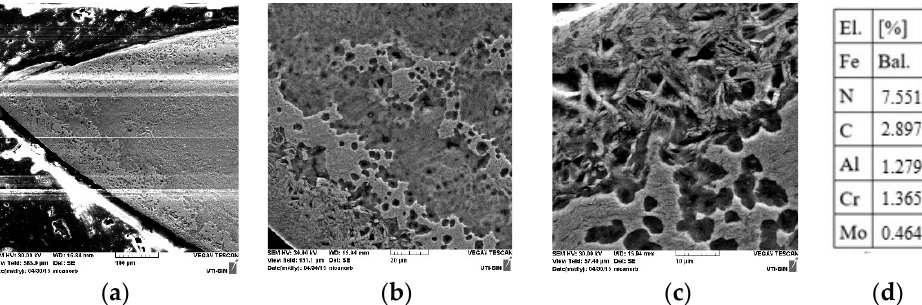
Figure 10. Active screen nitrided sample SEM micrographs, 30° area C, different scale: ( a ) 100 µm, ( b ) 20 µm, ( c ) 10 µm, and ( d ) mass concentration of elements per area.